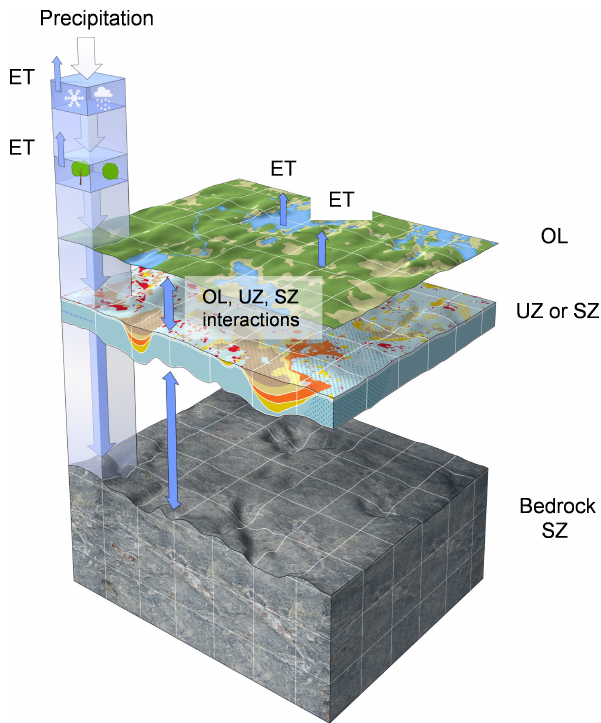
Figure 3. Schematic of a general Mike SHE model setup. Pre- cipitation falls on the ground as rain or snow. Evapotranspiration (ET) processes include canopy interception, open surface evapora- tion, root uptake, and soil evaporation from the unsaturated zone (UZ). The overland flow (OL), saturated zone (SZ), and UZ interact depending on the saturation level. The SZ is divided into 10 cal- culation layers (CLs), while the UZ has a much finer description. Streamflow is modelled through Mike 11 and is not restricted to the Mike SHE resolution. The figure is used courtesy of SKB. Figure illustrator: LAJ.